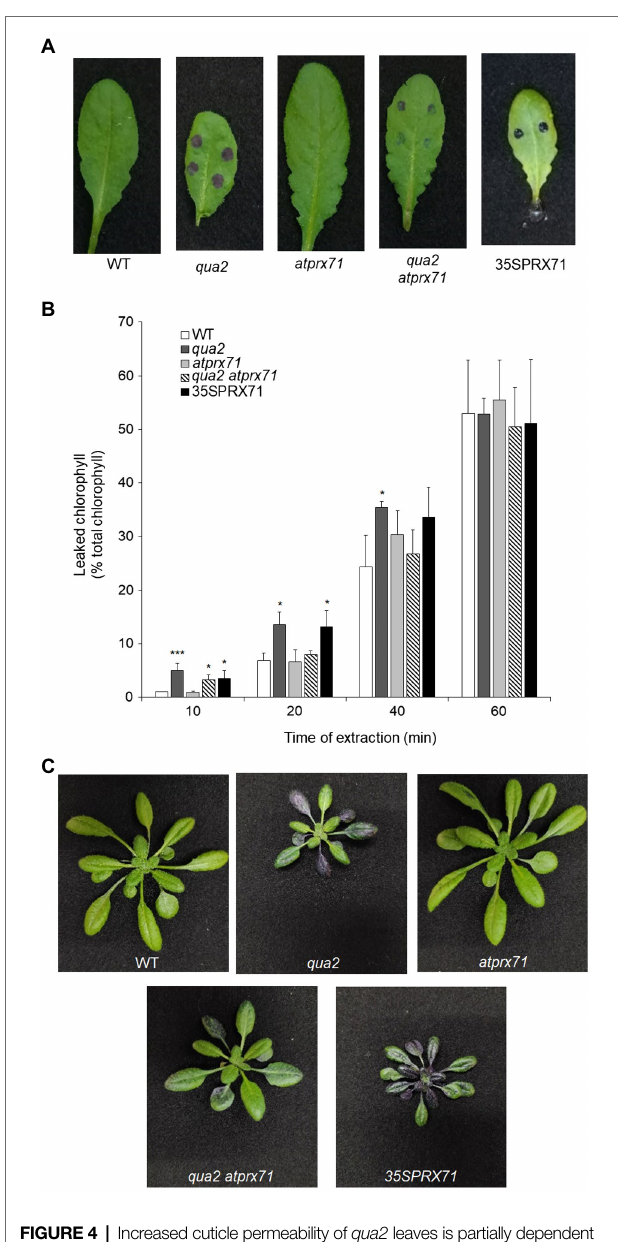
FIGURE 4 | Increased cuticle permeability of qua2 leaves is partially dependent on AtPRX71 . Permeability of the cuticle of fully expanded rosette leaves (A) of five-week-old Col-0 (WT), qua2 , atprx71 , qua2 atprx71 , and 35S::AtPRX71 #22 (35SPRX71) plants was determined by toluidine blue staining. (B) The amount of chlorophyll leached from rosette leaves as in (A) was measured after incubation in 80% EtOH at the indicated times. Bars indicate average concentration ± SD ( n = 3). For each time point, asterisks indicate significant differences, according to Student’s t-test between WT and mutants (* p < 0.05; *** p < 0.01). These experiments were repeated three times with similar results. (C) Toluidine blue staining of the entire rosette of five-week-old plants. Representative images of at least five plants per genotype are